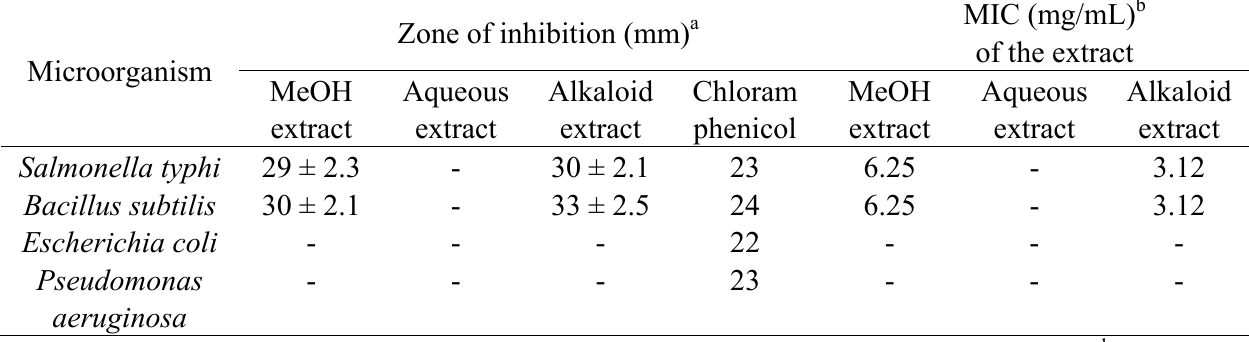
Table 2. Antimicrobial activity (zone of inhibition and MIC a ) of Mitragyna speciosa Leaf extract compared with commercial antibiotic 30 μ g/mL